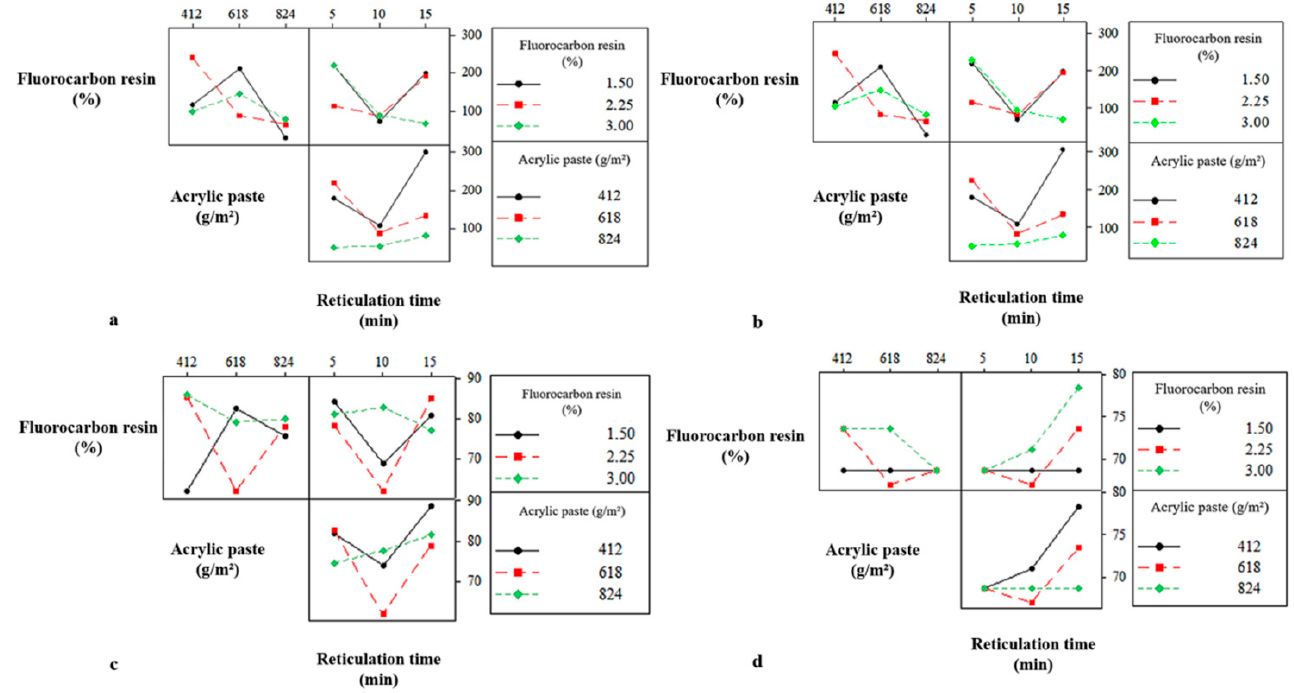
Figure 2. Interaction plots of: ( a ) air permeability (L·m − 2 ·s − 1 ); ( b ) windproofness (L·m − 2 ·s − 1 ); ( c ) WVPI (%); and ( d ) RWP (Schmerber).